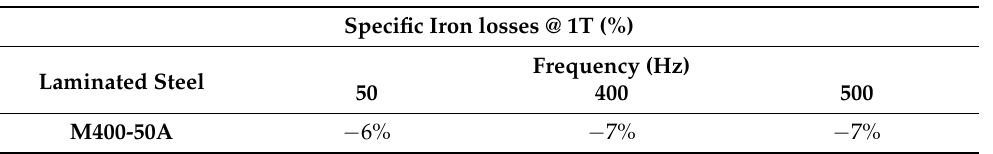
Figure 15. Specific iron losses (@1T and 50 Hz) percentage reduction for SMC samples and lami- nated steel. Table 4. Effect of the operating temperature condition on specific iron losses % reduction (comparison between 20 ◦ C and 125 ◦ C) in a laminated